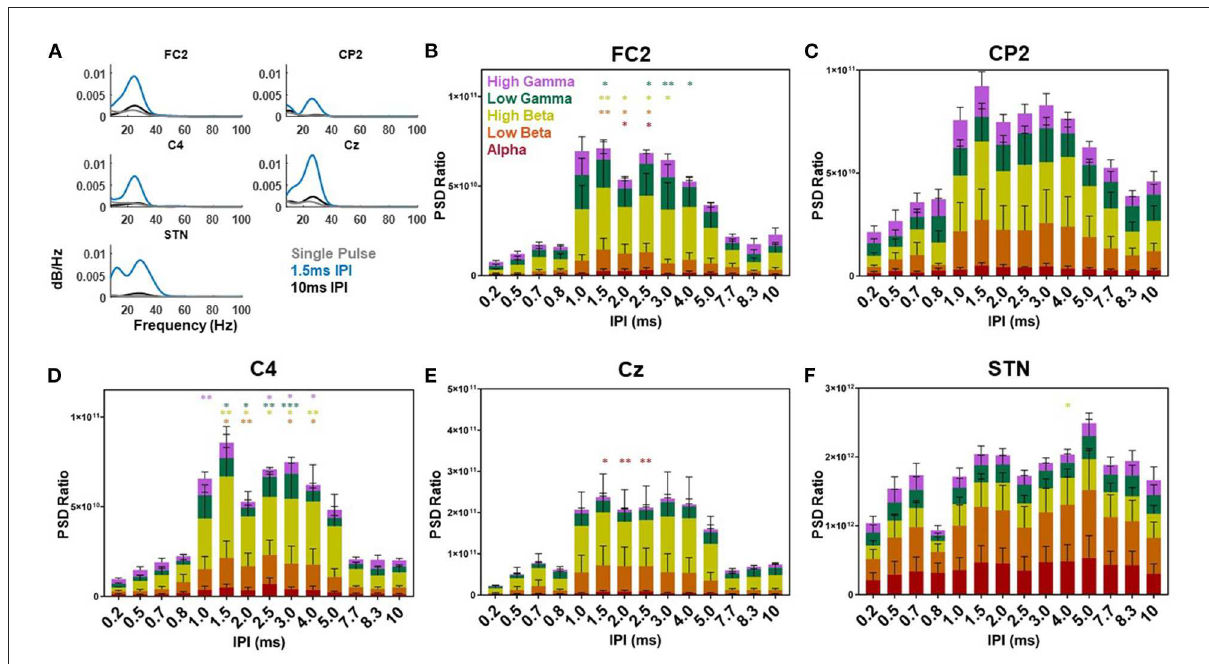
FIGURE7 Single participant and group power spectral density results. Example power spectral density of the EP waveform for the single (gray), 1.5 (blue), and 10ms (black) IPI across the FC2, CP2, C4, Cz, and STN-LFP channels from participant three while on medication (A) . The power spectral density ratio of the cortical EP from the FC2, CP2, C4, Cz, and STN-LFP channel with each IPI over the resting state power differentiated based on the average alpha (red), low beta (orange), high beta (yellow), low gamma (green), and high gamma (purple) frequencies across all participants ( B–F , respectively). Significant differences are denoted by the single and double asterisks ( P < 0.05 and P < 0.001, respectively) with error bars reflecting standard error of the